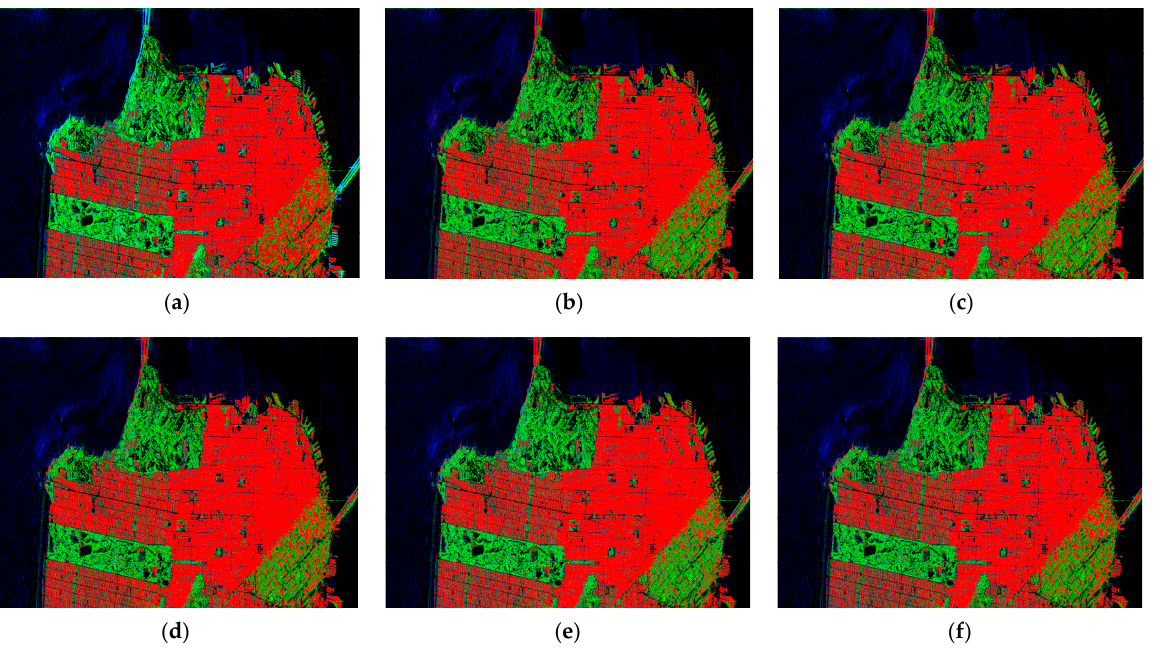
Figure 17. Building detection results of ALOS-2/PALSAR-2 dataset. ( a ) Ground truth image, ( b ) Y4R, ( c ) G4U, ( d ) 6SD, ( e ) 7SD, ( f ) MRDD-5SD. Table 5. Comparison of detection results from different decomposition methods. Decomposition Methods